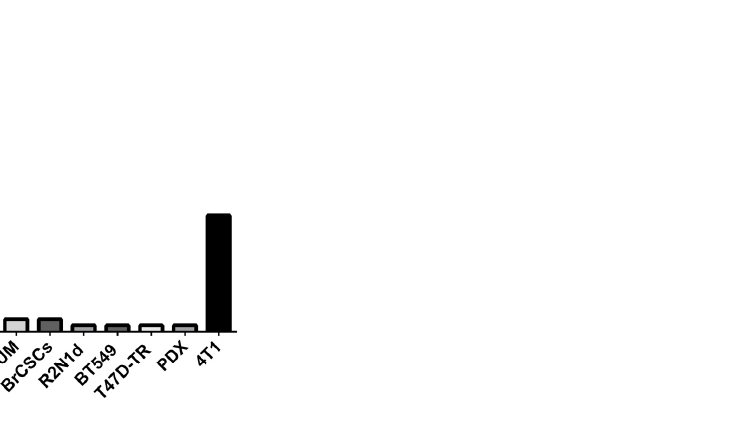
Figure 2. Number of experiments regarding the murine strain used in the articles analyzed. NOD: non-obese diabetic; SCID: severe combined immunodeficient mice; and NSG: NOD SCID gamma mouse.